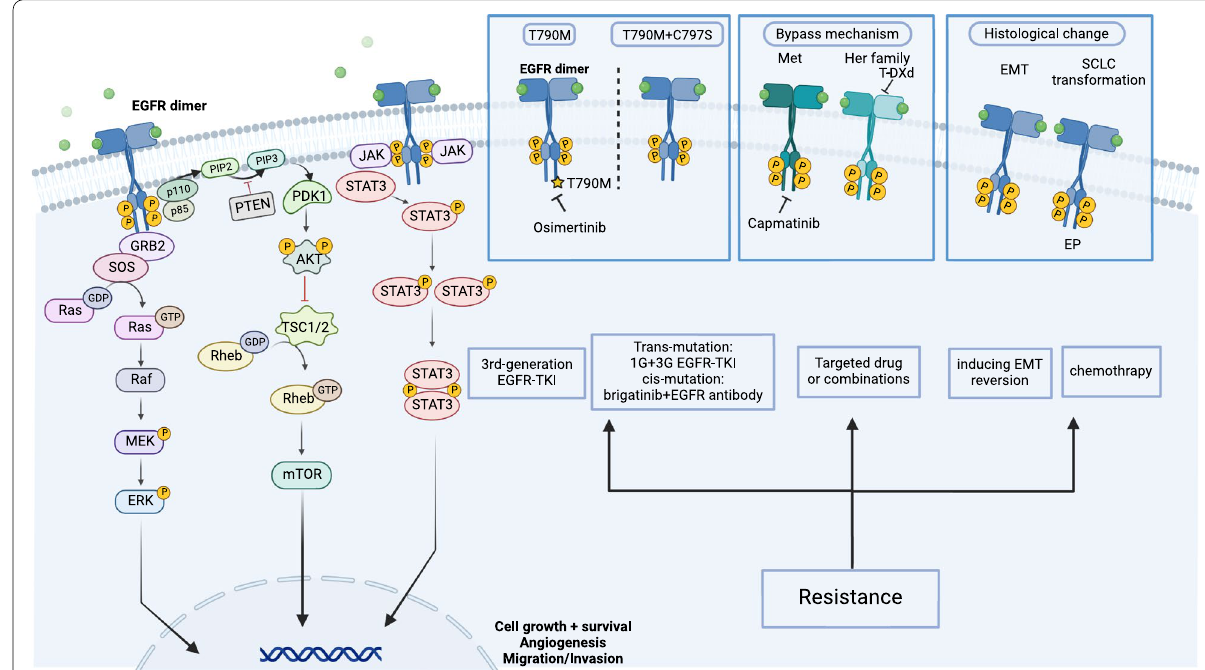
Fig. 2 Signaling pathway, resistance mechanisms, and treatment strategies of EGFR. Overview of the EGFR signaling pathway, with a focus on major resistance mechanisms and related potential treatment strategies. After binding with the ligands, EGFR forms a dimer, thereby activating downstream signaling pathways, such as PI3K/AKT/mTOR, RAS/RAF/MEK/ERK, and JAK/STAT, to control cell growth and division (as shown on the left). The acquired resistance mechanisms to EGFRtargeted therapies include secondary mutation of EGFR gene, activation of alternative or downstream signaling pathways, and tumor histological transformation. Secondary mutation of EGFR gene includes EGFR T790M, C797S, and others. MET and HER2 are identified as bypass pathway resistance alterations. With regard to histological transformation, it was reported cases related with EMT and histological transformation to SCLC. Some of the latest treatments against EGFR TKIs resistance are also briefly shown in the figure(as shown on the right). EGFR, epidermal growth factor receptor; PI3K, phosphatidylinositide 3-kinases; mTOR, mechanistic target of rapamycin; JAK, Janus kinase; STAT, signal transducer and activator of transcription; MET, hepatocyte growth factor receptor; HER2, human epidermal growth factor receptor; EMT, epithelial to mesenchymal transition; SCLC, small cell lung